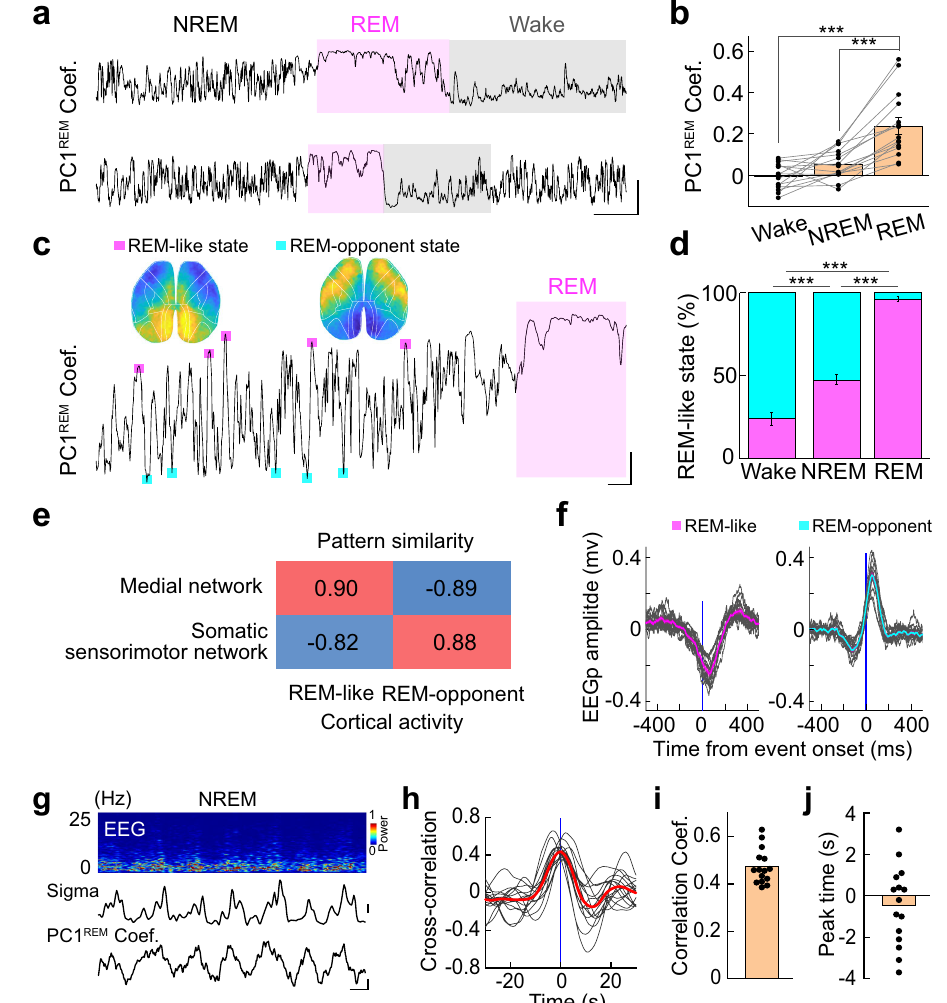
Fig. 5 | Occipital activity dynamics during the sleep-wake cycle. a Dynamic changeofthePC1 REM indifferentbrainstatesfromtwoexampletraces.Scale,1and 20s. The black line is the Pearson correlation coef fi cient between each image frameandthePC1 REM . b Quanti fi cationofPC1 REM dynamicsindifferentbrainstates. P <0.0001 for both Wake vs . REM and NREM vs . REM; Two-tailed paired t -test. n =15recordingsfrom5mice.Dataaremean±SEM. c DynamicchangeoftheREM- likestateduringNREM.ThemagentaandcyansquaresmarkedtheREM-likeevents and REM-opponent events, respectively. The cortical activity patterns corre- sponding to the twostateswereshownabovethecorrelation curve.Scale,0.3and 5s. d Quanti fi cation of the REM-like state (magenta) and REM-opponent state (cyan) in different brain states. P <0.0001 for all the comparisons; Two-tailed